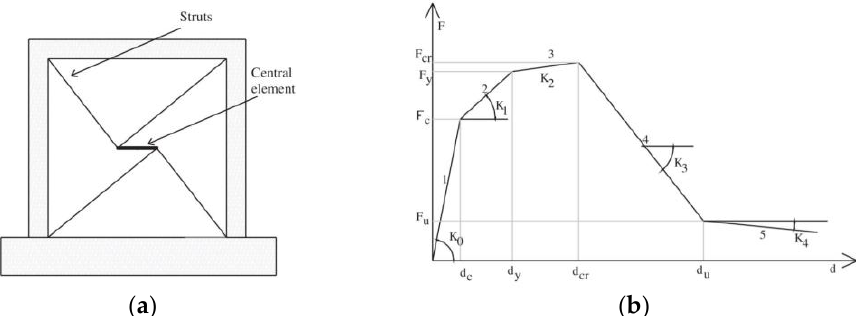
Figure 10. Simplified macro-model, ( a ) Representation of elements, and ( b ) monotonic behaviour curve [270].